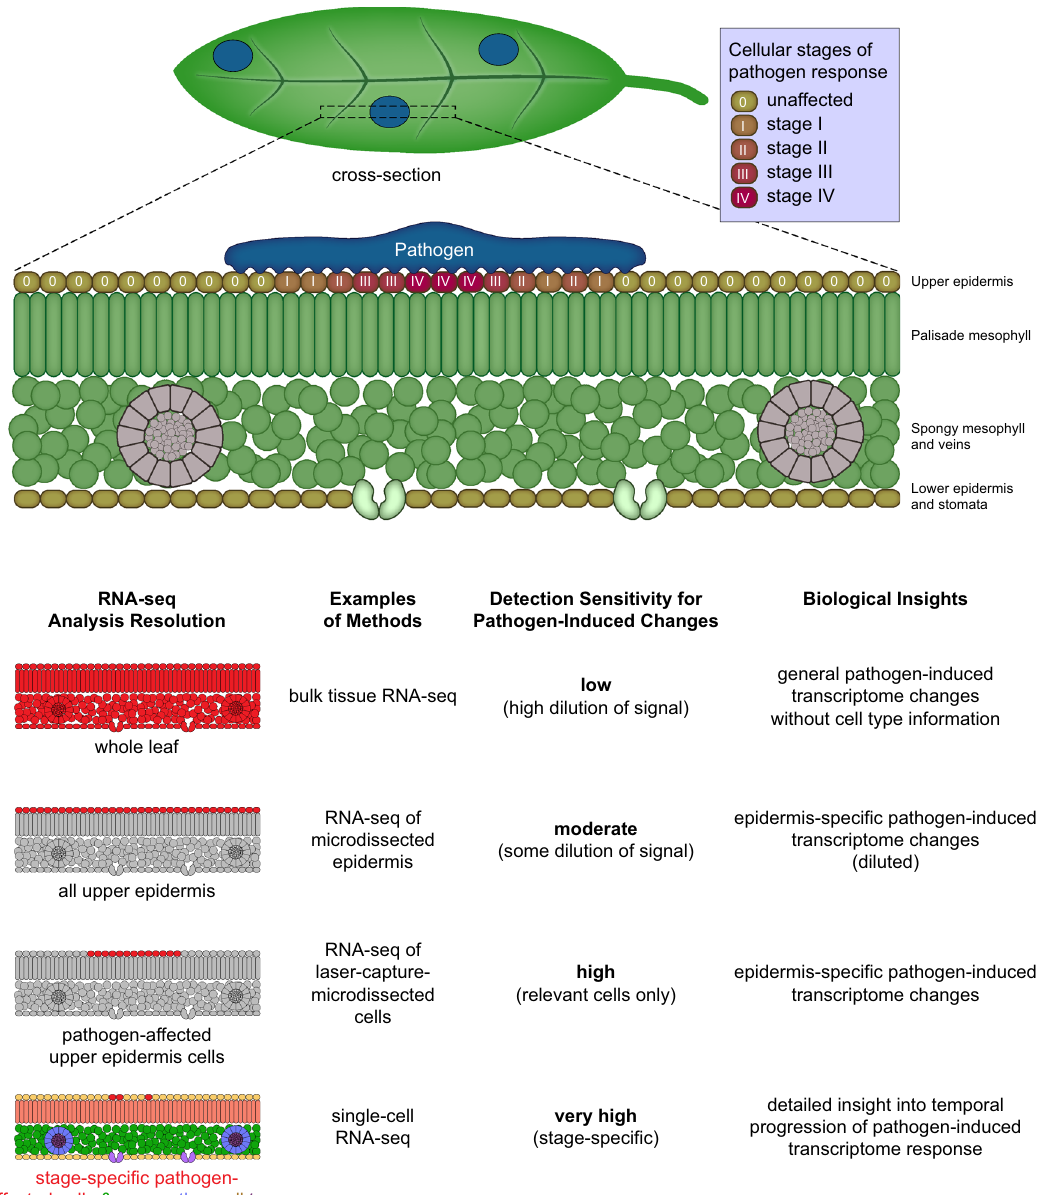
Fig. 2 Advantages of using single-cell RNA-seq to study plant-pathogen interactions. Relatively few plant cells interact directly with most pathogens. However, these local interactions often determine disease severity. Thus, understanding gene expression in these few cells could be valuable for enhancing resistance. Unfortunately, bulk tissue RNA-seq greatly dilutes the signal from interacting cells, and signals from genes upregulated throughout the leaf in response to pathogens can mask expression changes in the interacting cells. While methods like microdissection can improve the signal-to-noise ratio to a degree, they are labor-intensive and not universally applicable to all pathogens. Thus, the increased cellular resolution promised by single-cell RNA-seq could revolutionize our understanding of plant-microbe and commensal microorganisms typically interact with very speci fi c subpopulations of cells in a host plant, with many (or most) plant cells not in direct contact with or infected by speci fi c microbes. For example, arbuscular mycorrhizal fungi speci fi cally target only a subset of cortical cells of the plant root. Current methods of performing RNA-seq on bulk tissue or cell popula- tions isolated by fl uorescence-activated cell sorting (FACS) of reporter-labeled plant lines massively dilute any signal originating from affected cells in the plant (Fig. 2). Micro fl uidic-based single- cell RNA-seq, in combination with emerging spatial tran- scriptomics methods, holds great promise for elucidating